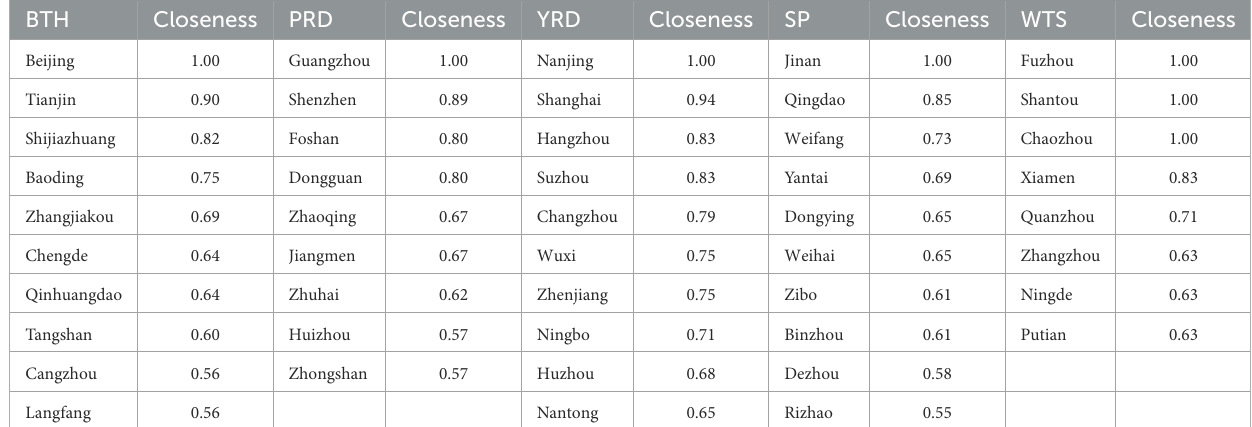
TABLE 14 Closeness centrality of the top 10 nodes in the low-carbon patent cooperation network in 2021. BTH Closeness PRD Closeness YRD Closeness SP Closeness WTS